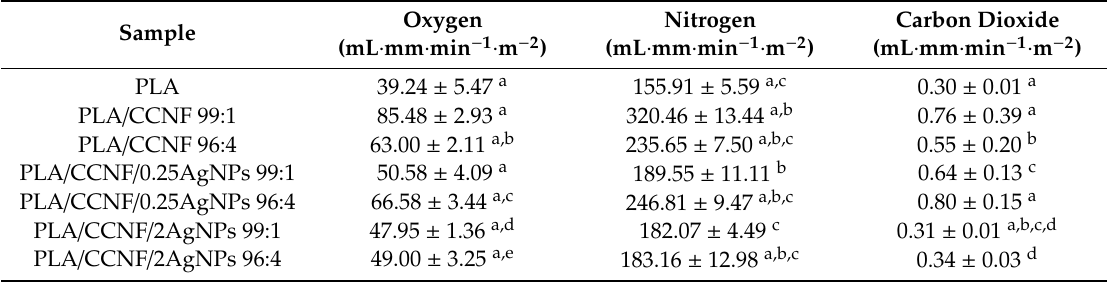
Table 3. Transmission rates of tested gases: oxygen, nitrogen, and carbon dioxide. Di ff erent superscript letters (a,b,c,d,e) in each column indicate significant di ff erences ( p < 0.05).